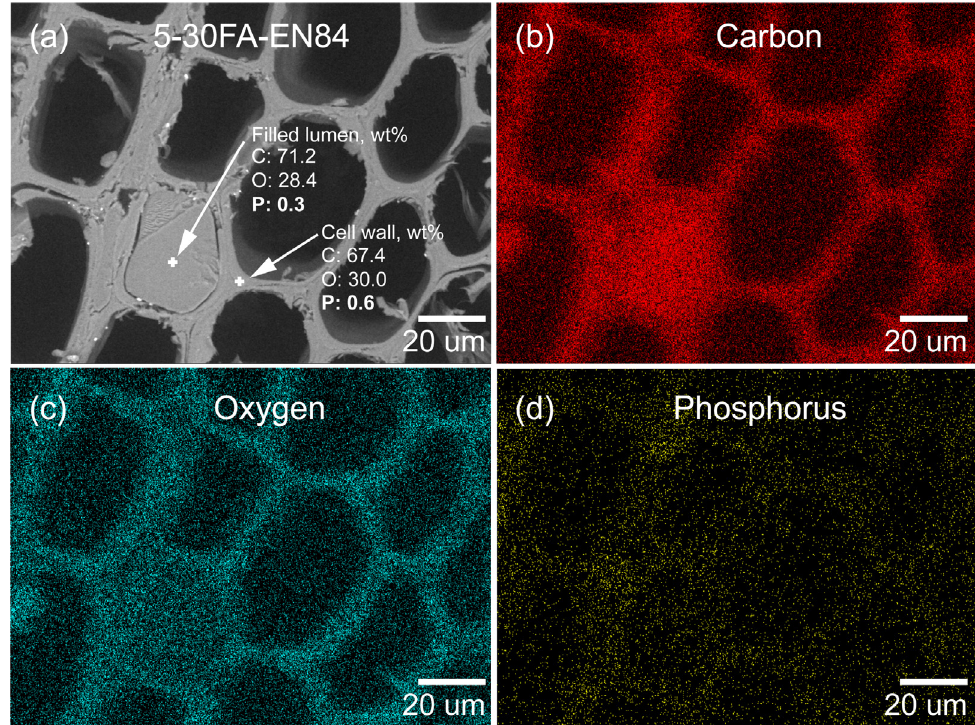
Figure 6. Low-vacuum SEM image and EDX spot analys-s of ( a ) cross-sectioned earlywood leached 5-30FA and corresponding EDX mapping of ( b ) carbon, ( c ) oxygen, and ( d ) phosphorus.